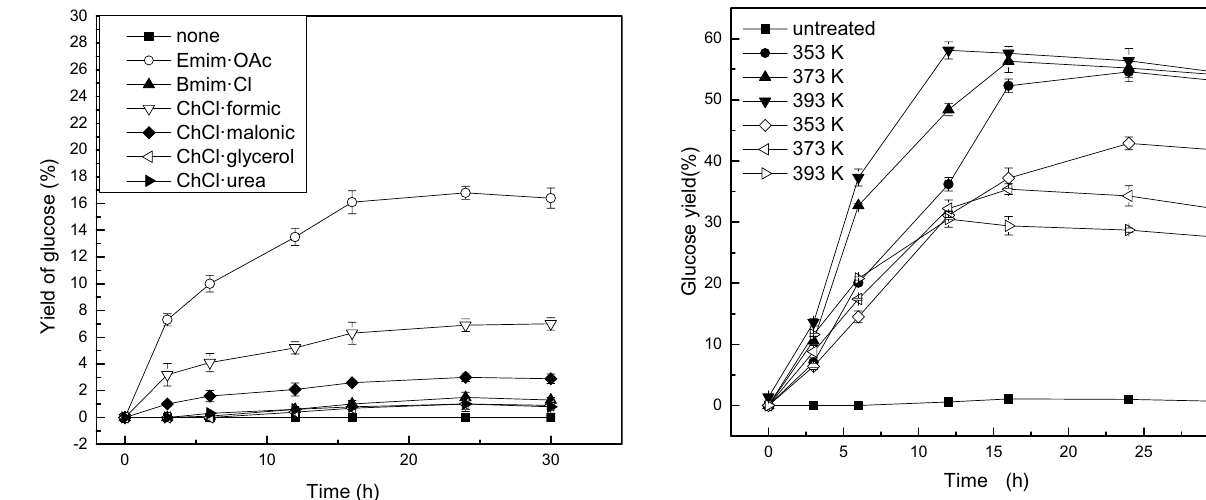
Fig. 2 Glucose yield from corn stover before and after pretreat- ment. Reaction conditions: 0.05 g corn stover, 0.1 g solid acid cata- lyst and 4 mL deionized water, 363 K